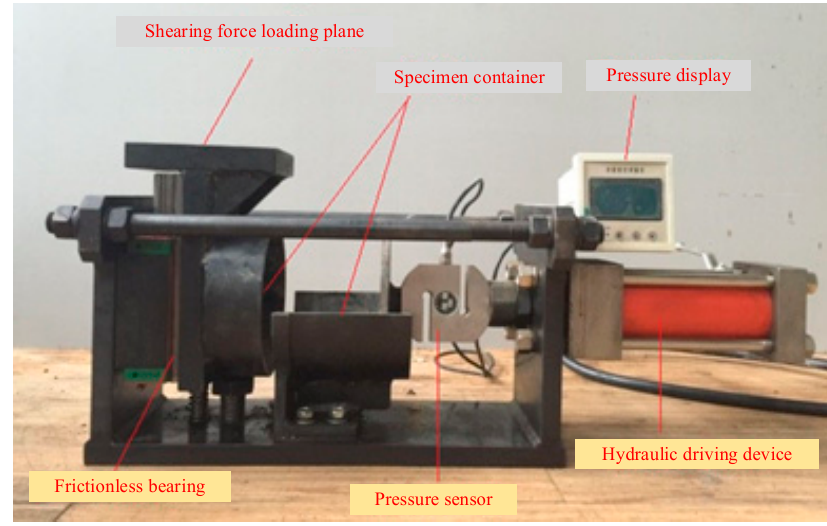
Figure 6. Interlayer shear tester.